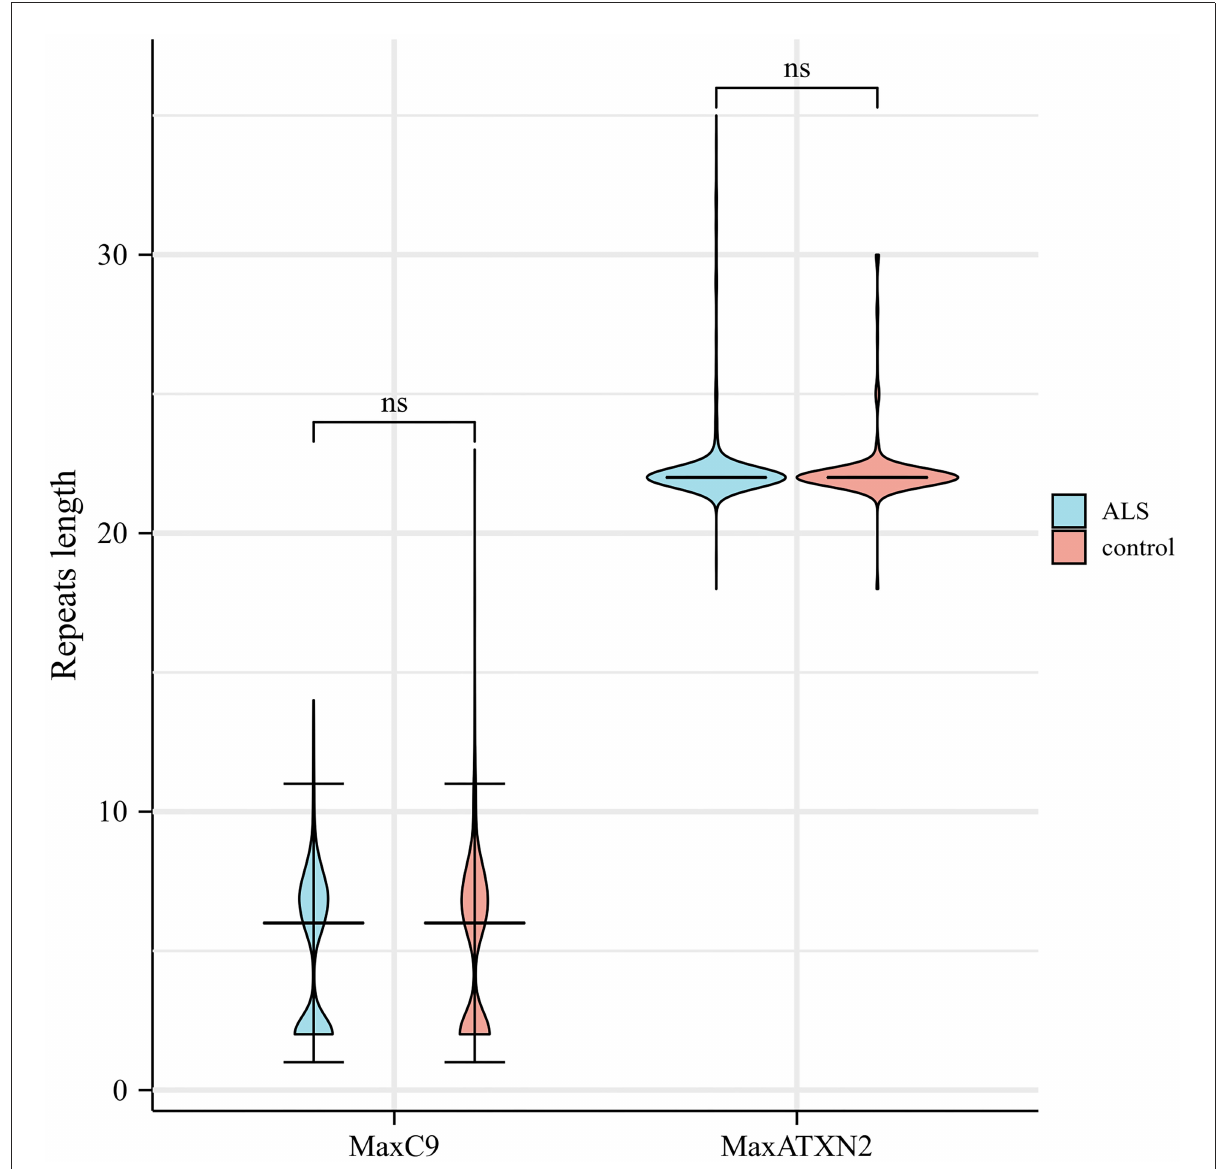
FIGURE1 Distribution of C9orf72 GGGGCC and ATXN2 CAG repeat length in patients with ALS and controls. ns, not significant.